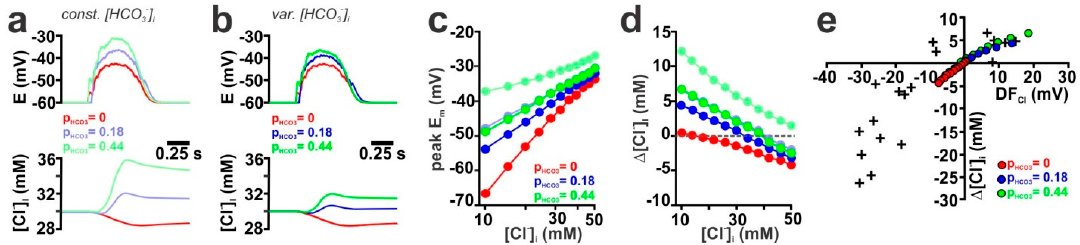
Figure 6. Influence of P HCO3 on GABA-induced [Cl ⁻ ] i transients in a reconstructed CA3 pyramidal neuron. ( a ) Time course of E m and average [Cl ⁻ ] i during a simulated GDP at different P HCO3 (g GABA = 0.789 nS, initial [Cl ⁻ ] i = 30 mM, [HCO3 ⁻ ] i = 14.1) using a model with a constant [HCO3 ⁻ ] i . ( b ) E m , average [Cl ⁻ ] i and [HCO3 ⁻ ] i during a simulated GDP at different P HCO3 (g GABA = 0.789 nS, initial [Cl ⁻ ] i = 30 mM,) using a model that implements dynamic [HCO3 ⁻ ] i . Note that membrane depolarization and [Cl ⁻ ] i transients are diminished upon implementation of dynamic [HCO3 ⁻ ] i . ( c ) Maximal E m during a GDP at different initial [Cl ⁻ ] i and P HCO3 using static (shaded lines) or dynamic [HCO3 ⁻ ] i (plain lines). ( d ) GDP-induced [Cl ⁻ ] i changes at different initial [Cl ⁻ ] i and P HCO3 using static (shaded lines) or dynamic [HCO3 ⁻ ] i (plain lines). ( e ) Dependency between DF Cl and